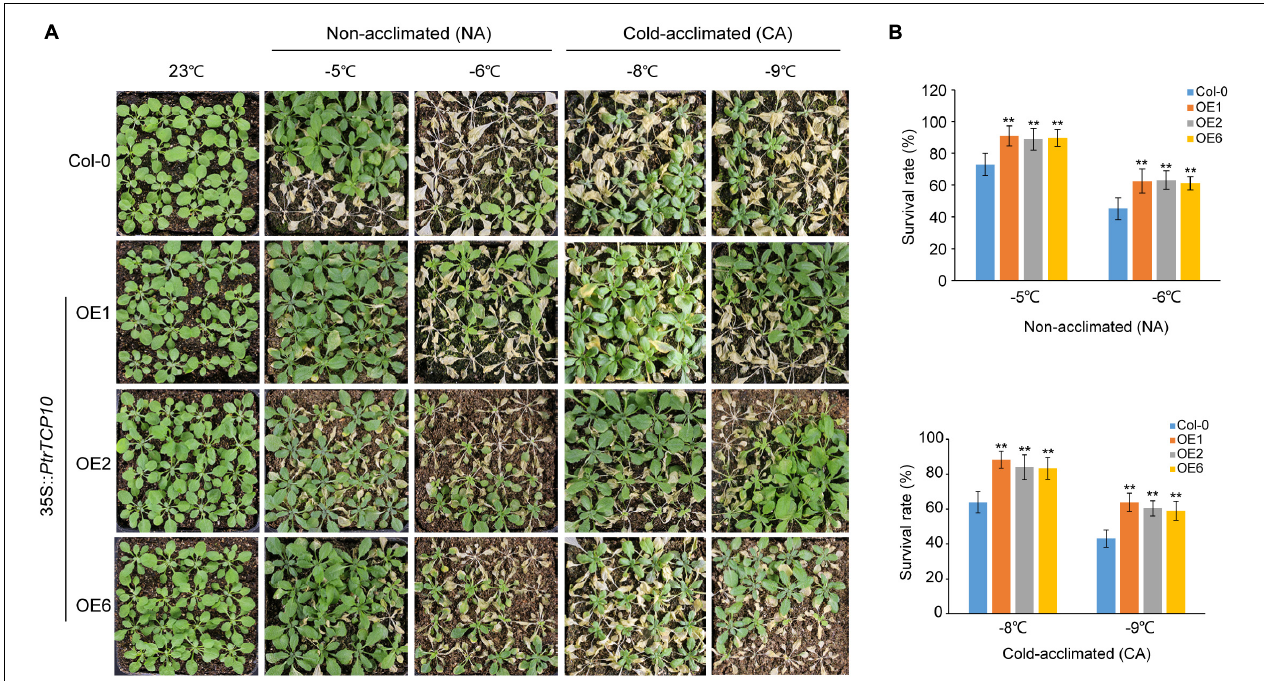
FIGURE 8 | Overexpression of PtrTCP10 in Arabidopsis increased freezing tolerance. (A) Comparison of the freezing tolerance phenotypes between 35S ::PtrTCP10 OE lines and wild-type (Col-0) under freezing treatments with or without cold acclimation. (B) Survival rate of the 35S:: PtrTCP10 OE lines and wild type after freezing treatments for 3 days. The values are the means of at least three replicates, and the error bars represent SD. Asterisks represent a significant difference between 35S:: PtrTCP10 OE lines and wild-type (** p < 0.01; Student’s t